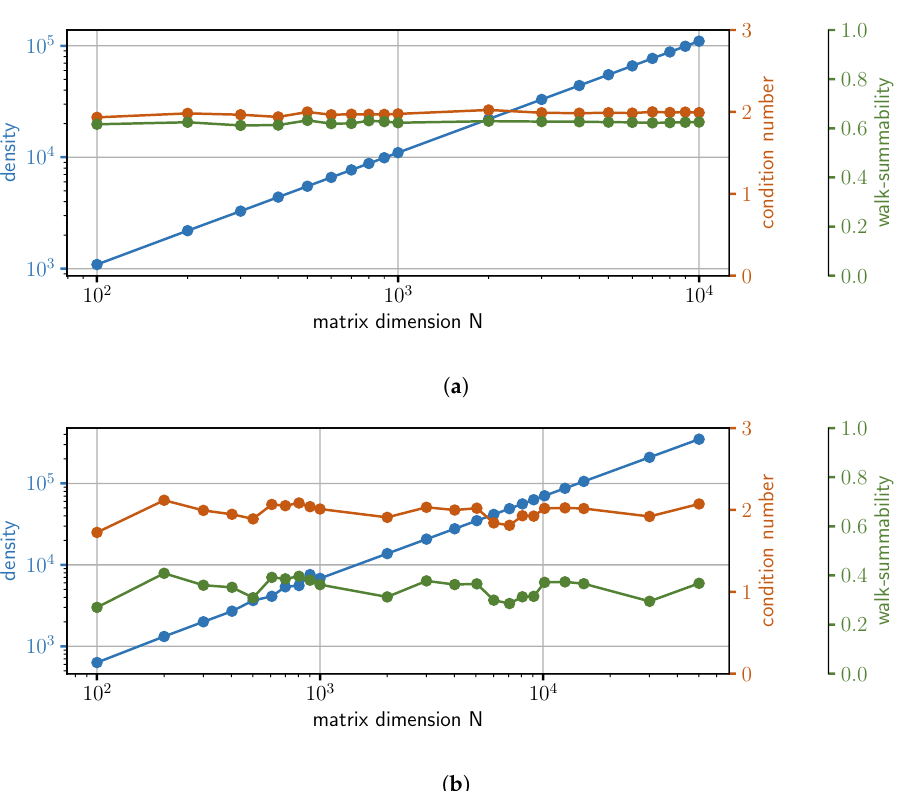
Figure 8. The two plots depict the main properties of the matrices in the Random LESs-set in ( a ) and FEM LESs-set in ( b ). Each dot on a curve represents one matrix (in total: 18 in ( a ) and 23 in ( b )). The plots show the density, i.e. the number of elements that are not zero in A , the condition number of A , and the walk-summability (see Equation (17)) dependent on the matrix dimension N